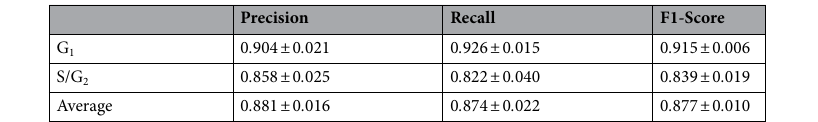
Table 2. Validation of nuclei classification (µ ± σ). Precision, Recall and F1-Score data are shown for class G 1 positive, class S/G 2 positive and average between both classes. Data represent mean ± standard deviation over the five models obtained by performing nested five-fold cross-validation.